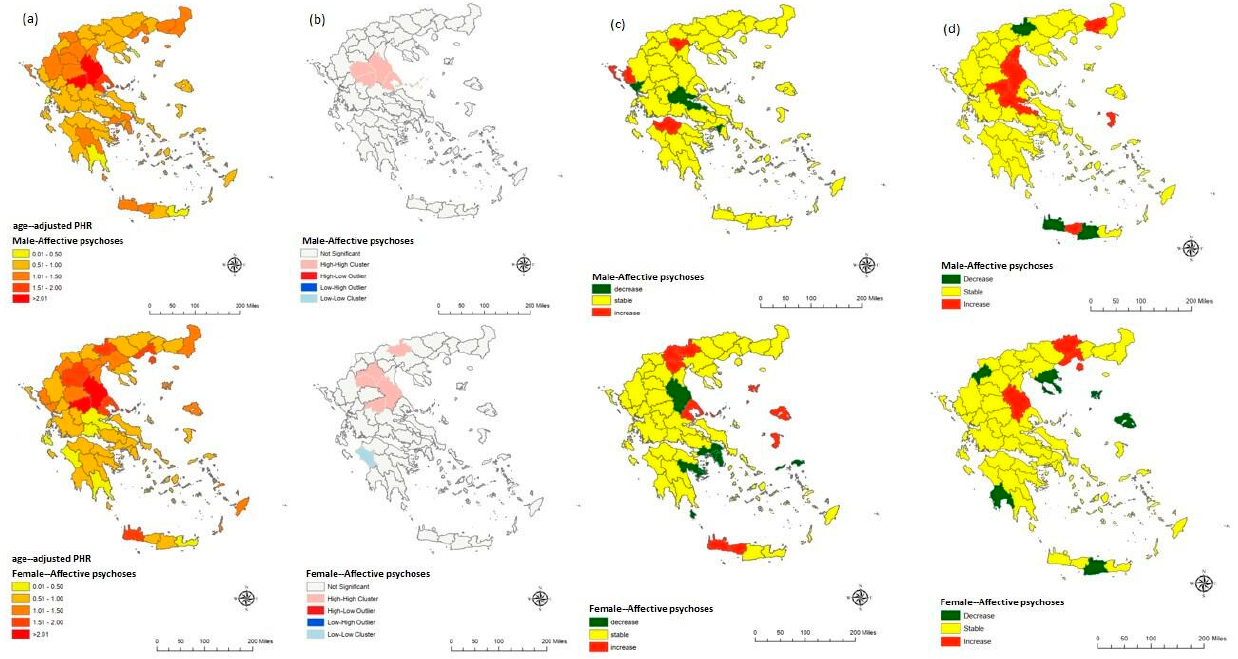
Figure 2. Descriptive ( a ), LISA ( b ) time series of annual PHR values ( c ) and hospitalization-days ( d ) maps per sex for hospitalizations of patients with affective disorders from 1999 to 2012 in Greece.